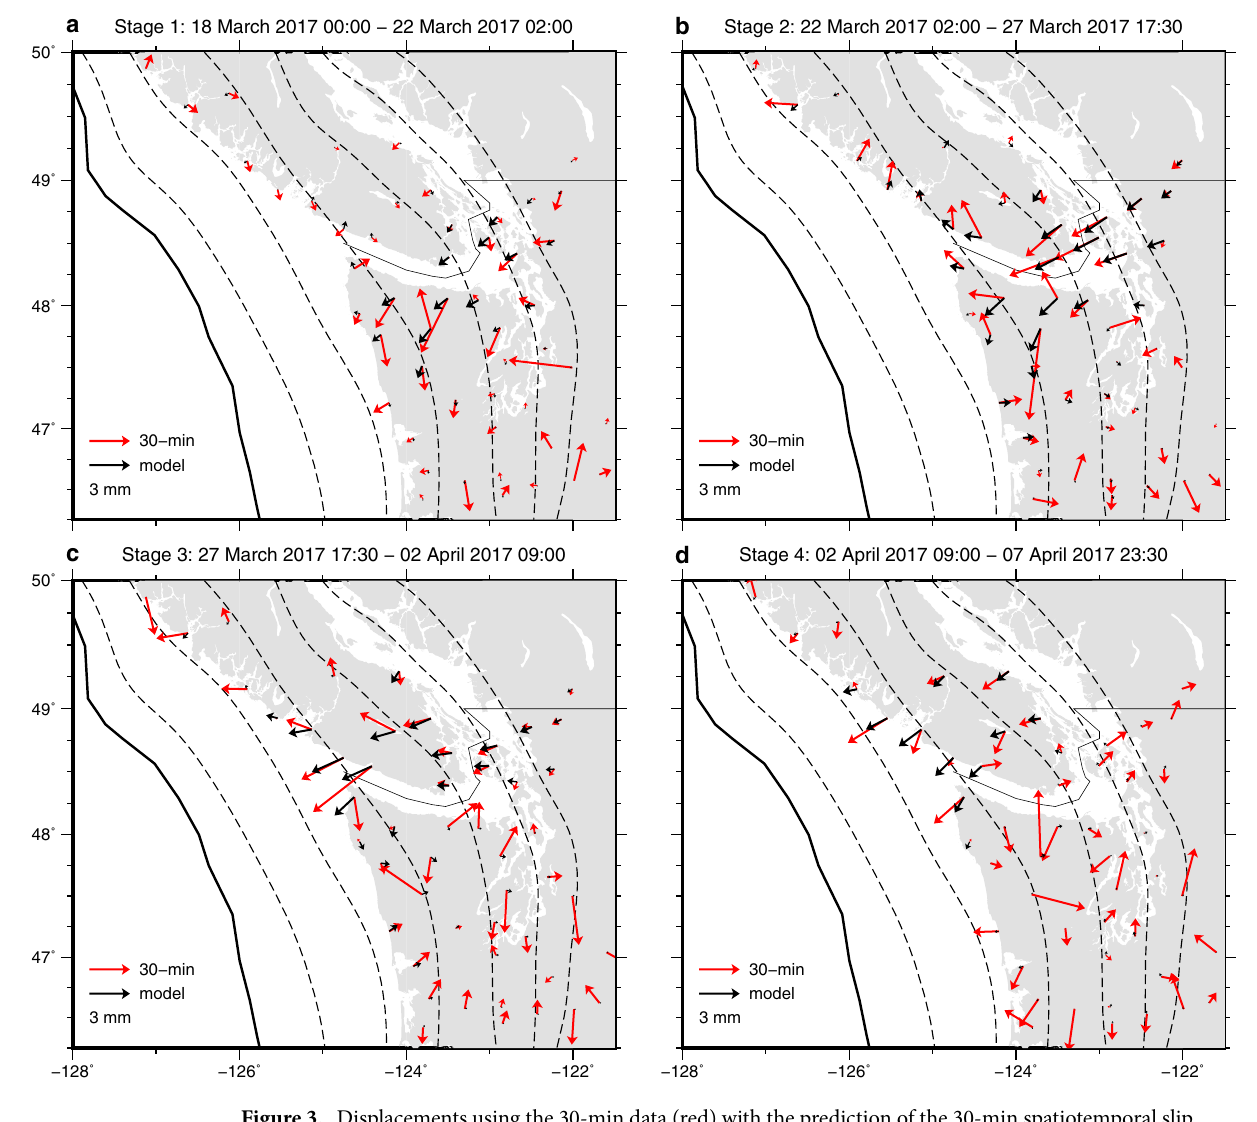
Figure 3. Displacements using the 30-min data (red) with the prediction of the 30-min spatiotemporal slip model (black) during four stages as labelled. The displacements in each stage for the 30-min data are obtained as the difference of the initial and the final positions, which are defined as the average positions during the 2 days centring at the first and the last epoch of each stage, respectively. Outliers deviating from the average by more than 3 times of the standard deviation were removed when taking the averages. Prior to the displacement computation, the 30-min time series were corrected for whole network translation estimated in the slip inversion. The model displacements are also obtained by the averaging using the same time window but without the outlier